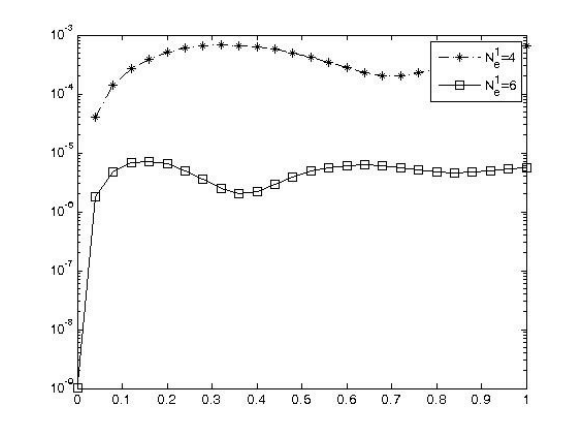
Fig. 3: Comparison of absolute errors function for y 1 ( t ) in Ex.